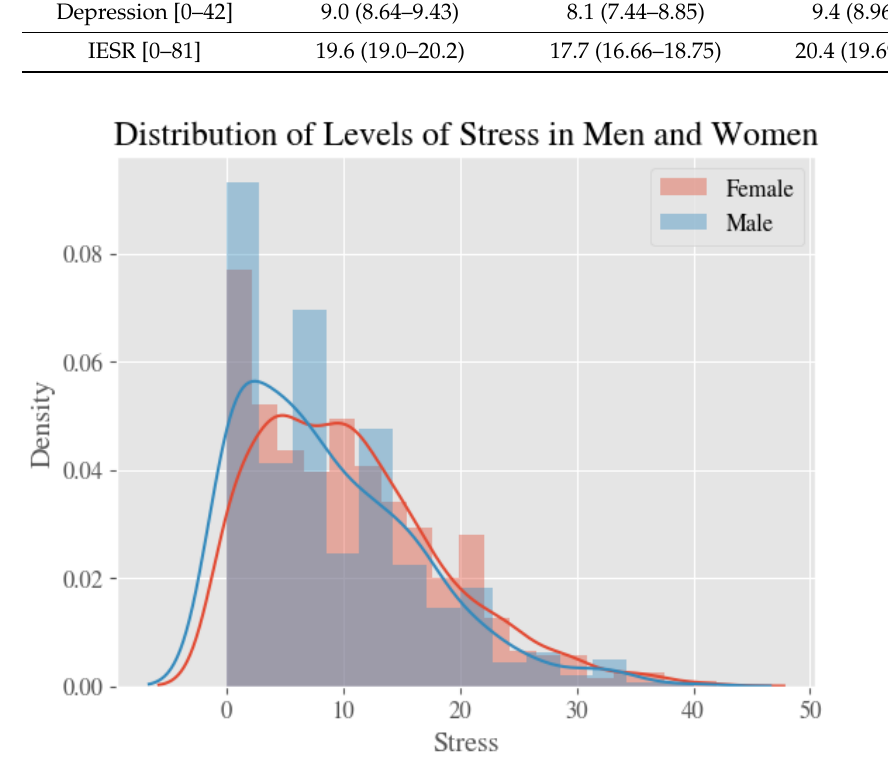
Figure 1. The Distribution of Levels of Stress in Men and Women.